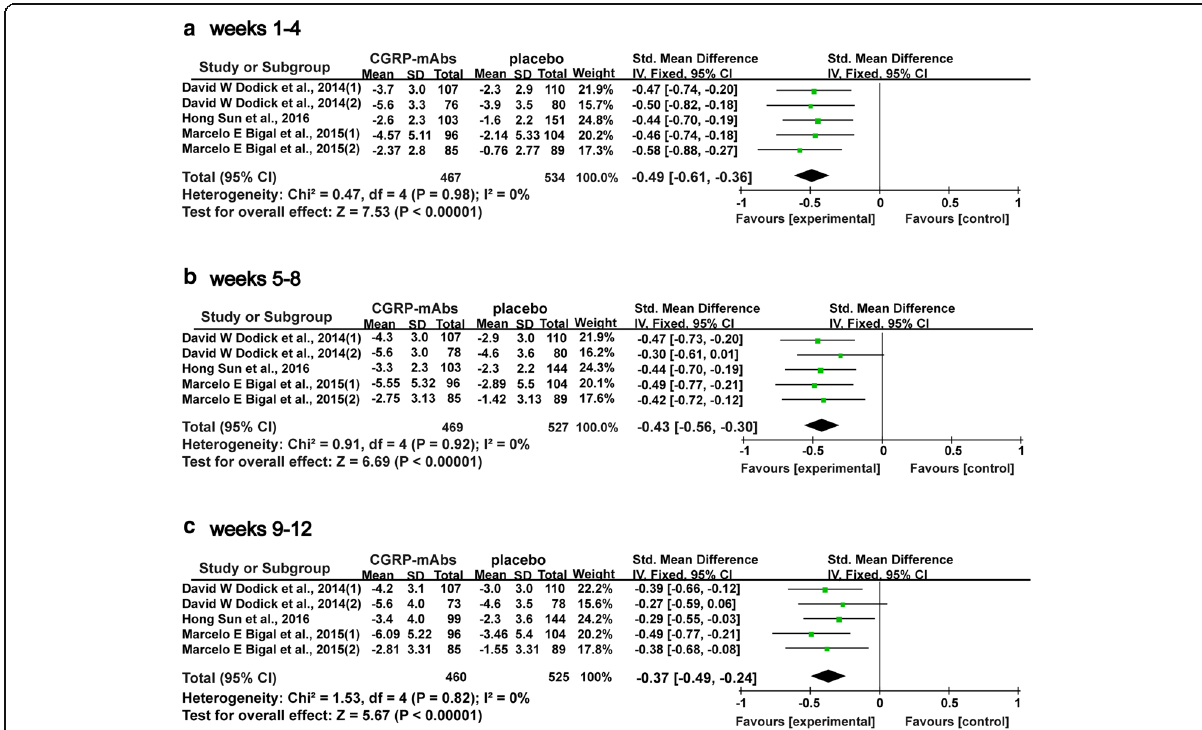
Fig. 4 Forest plot of the meta-analysis showed a significant decrease in the numbers of monthly migraine days after therapy with CGRP-mAbs compared with placebo from baseline to weeks 1 – 4, 5 – 8, and 9 – 12. a The numbers of monthly migraine days of CGRP-mAbs and placebo at weeks 1 – 4; b The numbers of monthly migraine days of CGRP-mAbs and placebo at weeks 5 – 8; c The numbers of monthly migraine days of CGRP-mAbs and placebo at weeks 9 – 12. CGRP-mAbs, monoclonal antibodies to CGRP and its receptor; IV, inverse variance; CI, confidence